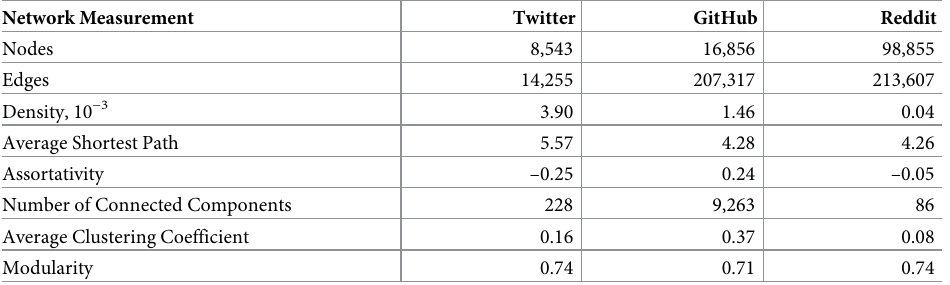
Table 1. Network topology analysis for Twitter, Reddit, and GitHub networks of users discussing CVEs.